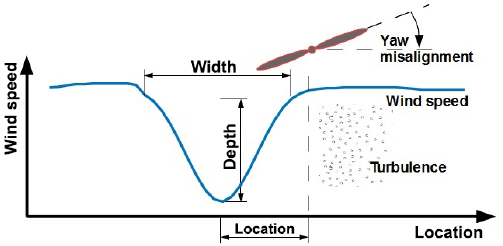
Figure 1. Visualization of the parameters used for describing the wake conditions in front of a